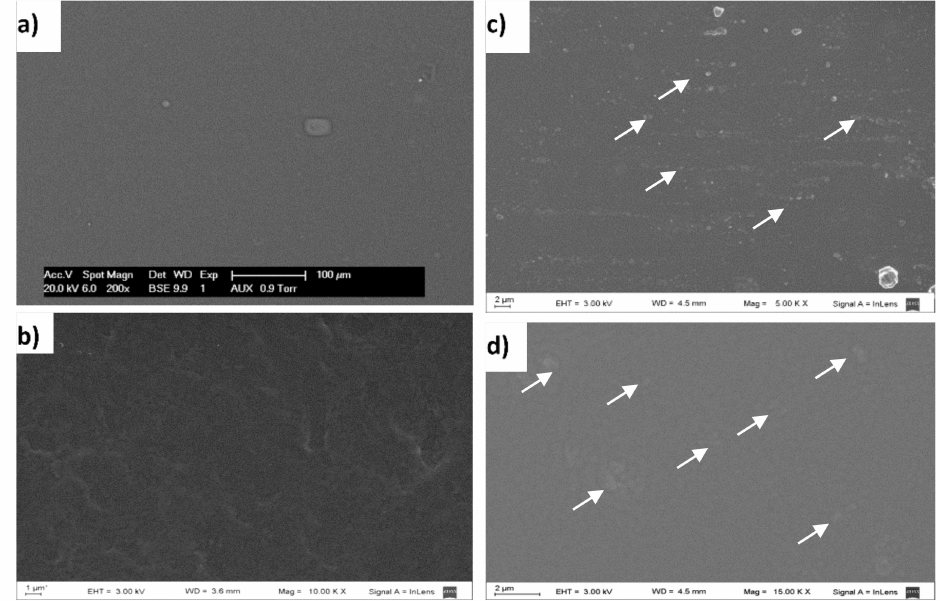
Figure 1. SEM micrographs of the film surface: ( a ) CF (films without KS), magnification: 200 × ; ( b ) KSF (films added with KS that was not retained in particles), magnification: 10 kX; ( c ) NKSPF (films added with NKSP), magnification: 5 kX; ( d ) AKSPF (films added with AKSP), magnification: 15 kX. Arrows point out NKSP and AKSP